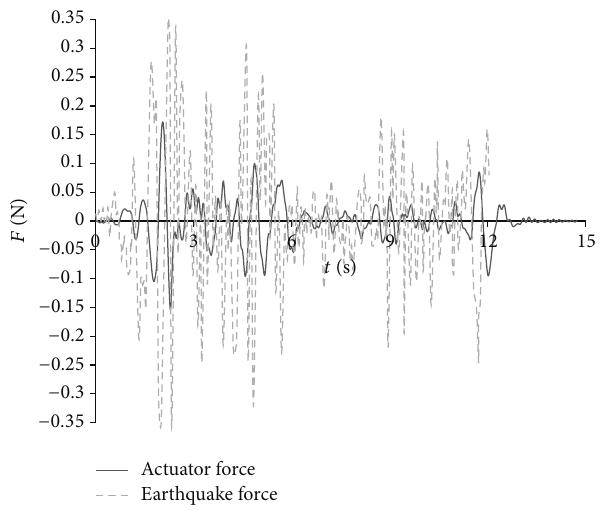
Figure 7: Comparison between the actuator and the earthquake forces in the case of using one actuator and one sensor.